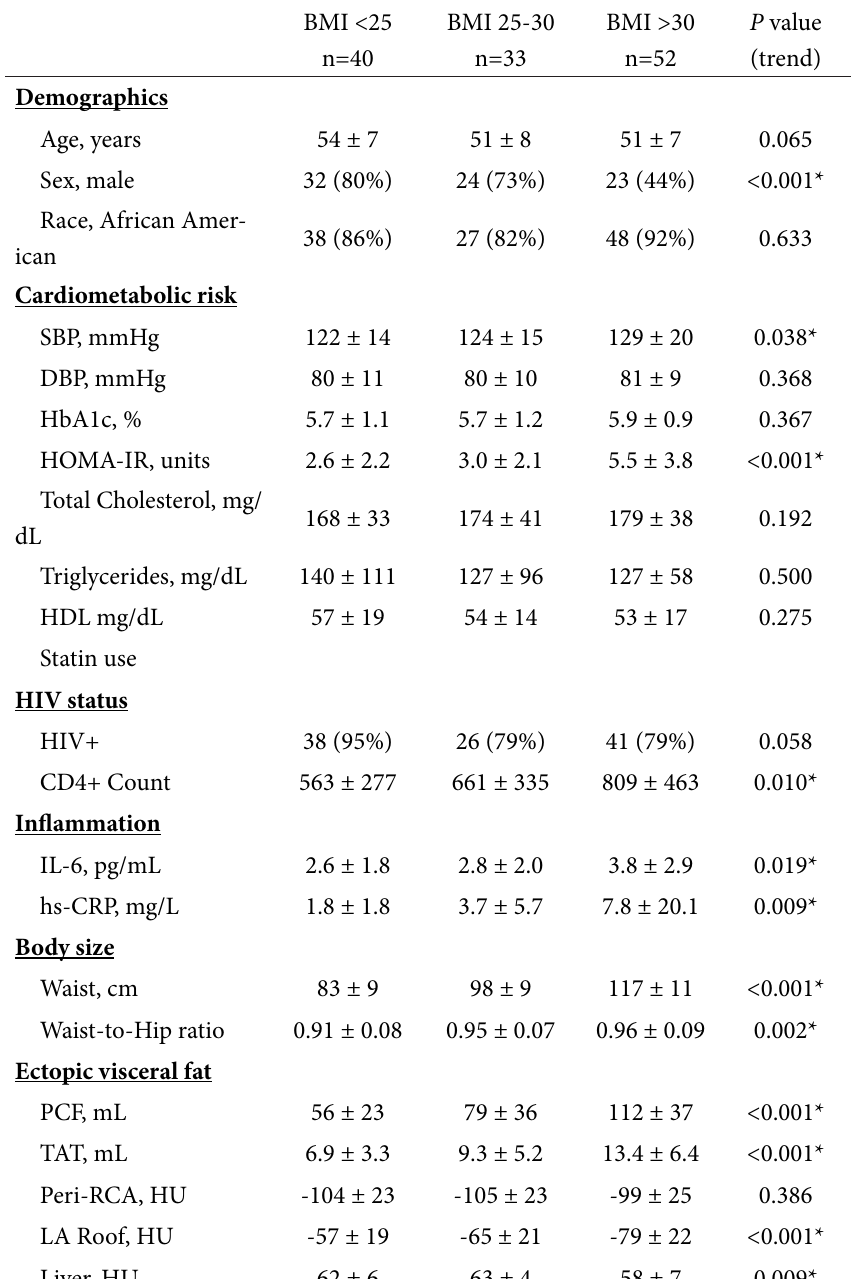
Supplementary Table. Participant Characteristics Stratified by